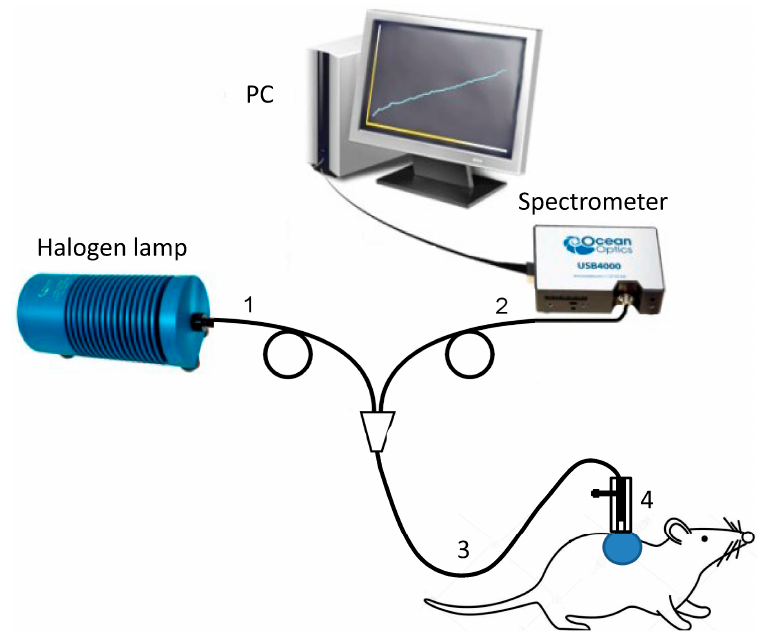
Figure 3. The scheme of the experimental setup for measurement of diffuse reflectance: 1 is the leg with lighting fibers, 2 is the leg with the collecting fiber, 3 is a leg with the 6-around-1 fiber bundle, and 4 is the holder of the probe.